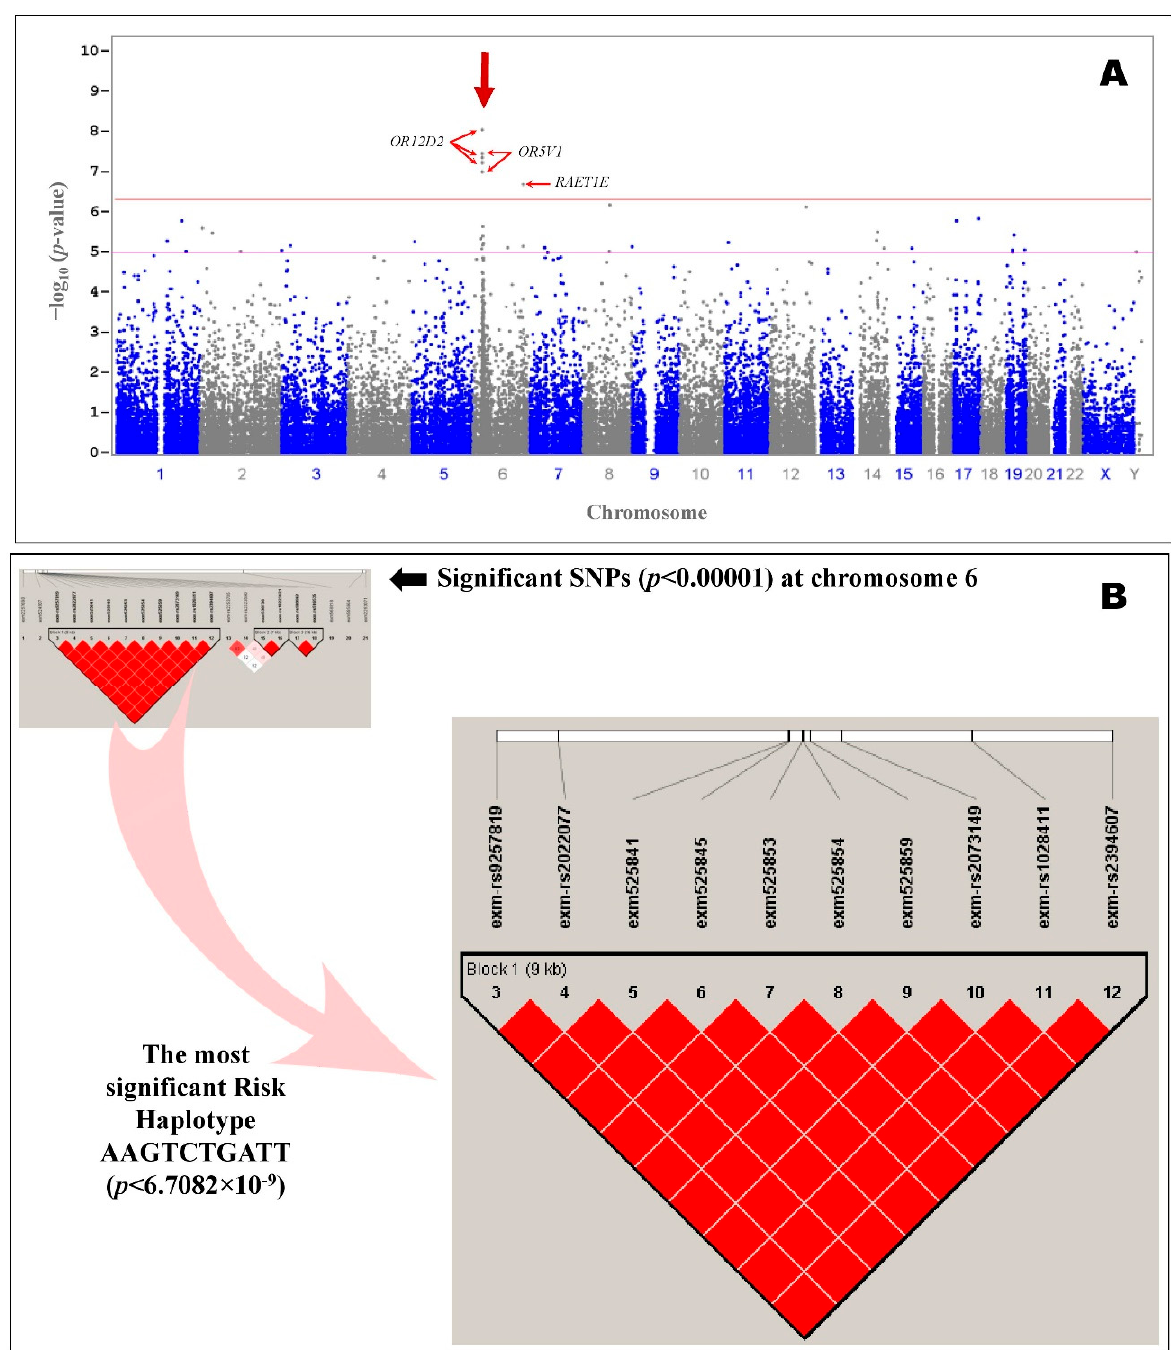
Figure 2. ( A ): Manhattan plot of putative functional exonic variants n = 243,345 in the molecular genetics of autism from the association study. The log10 ( p ) values from the association are plotted according to variant position on each chromosome. Positions of candidate genes of functional exonic variants at olfactory receptor genes on chromosome 6p22.1 for autism are indicated by red arrows. The horizontal red line indicates the preset threshold of p = 4.00 × 10 − 7 . The horizontal pink line indicates the suggestive threshold of p = 1.00 × 10 − 5 . ( B ): Genetic association of the most significant variants at the OR12D2 and OR5V1 genes in the chromosome 6p22.1 region and linkage disequilibrium results in subjects of Arab ancestry with autism. Block 1 indicates the most significant risk haplotype, AAGTCTGATT ( p = 6.7082 × 10 − 9 ), associated with the Arab-ancestry autism subjects.